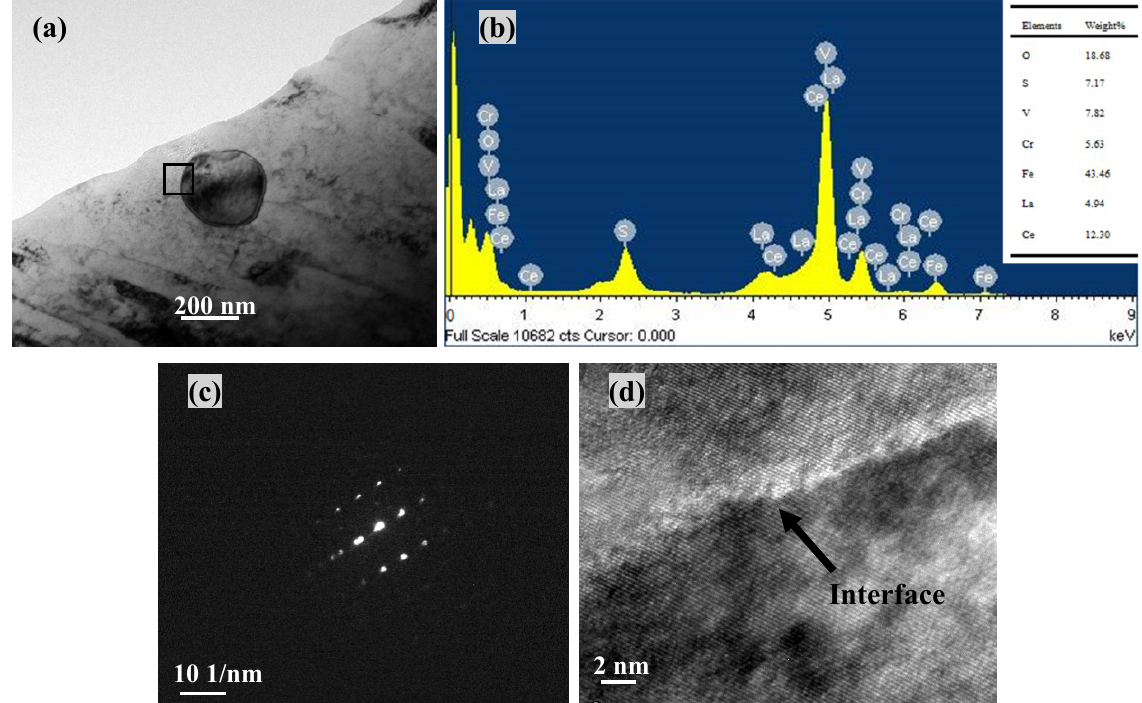
Figure 6. RE inclusion analyzed by TEM: ( a ) TEM image of inclusion; ( b ) EDS analysis of inclusion; ( c ) Diffraction patterns for corresponding to the inclusion; ( d ) HRTEM of the